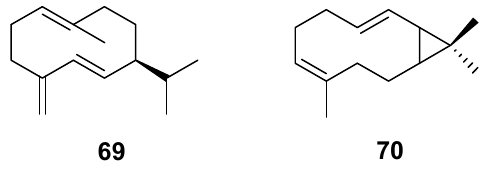
Figure 2. Chemical structures of sesquiterpenes isolated from the genus Gnaphalium